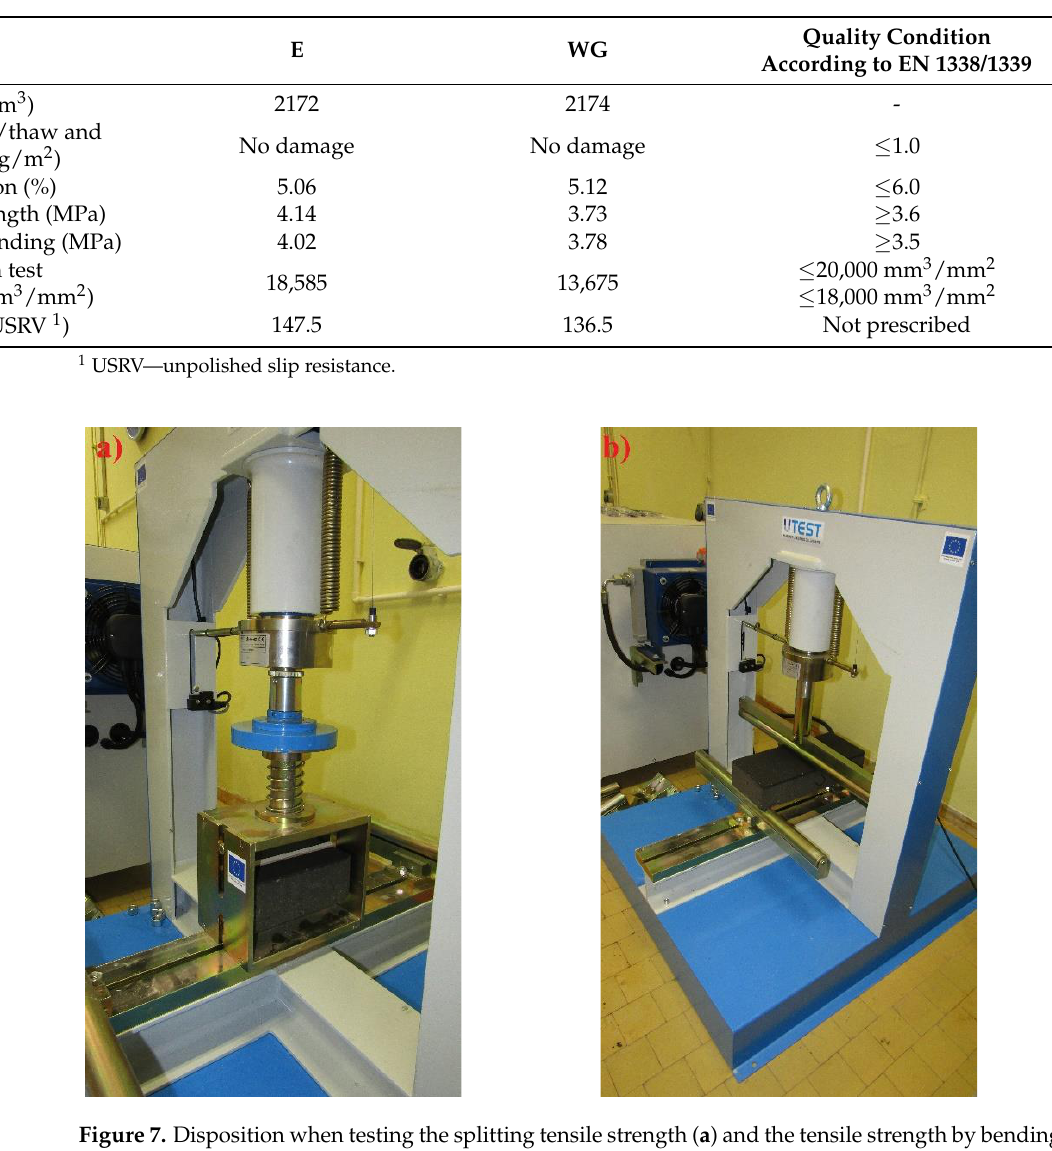
Table 5. Test results of concrete paving blocks and flags.